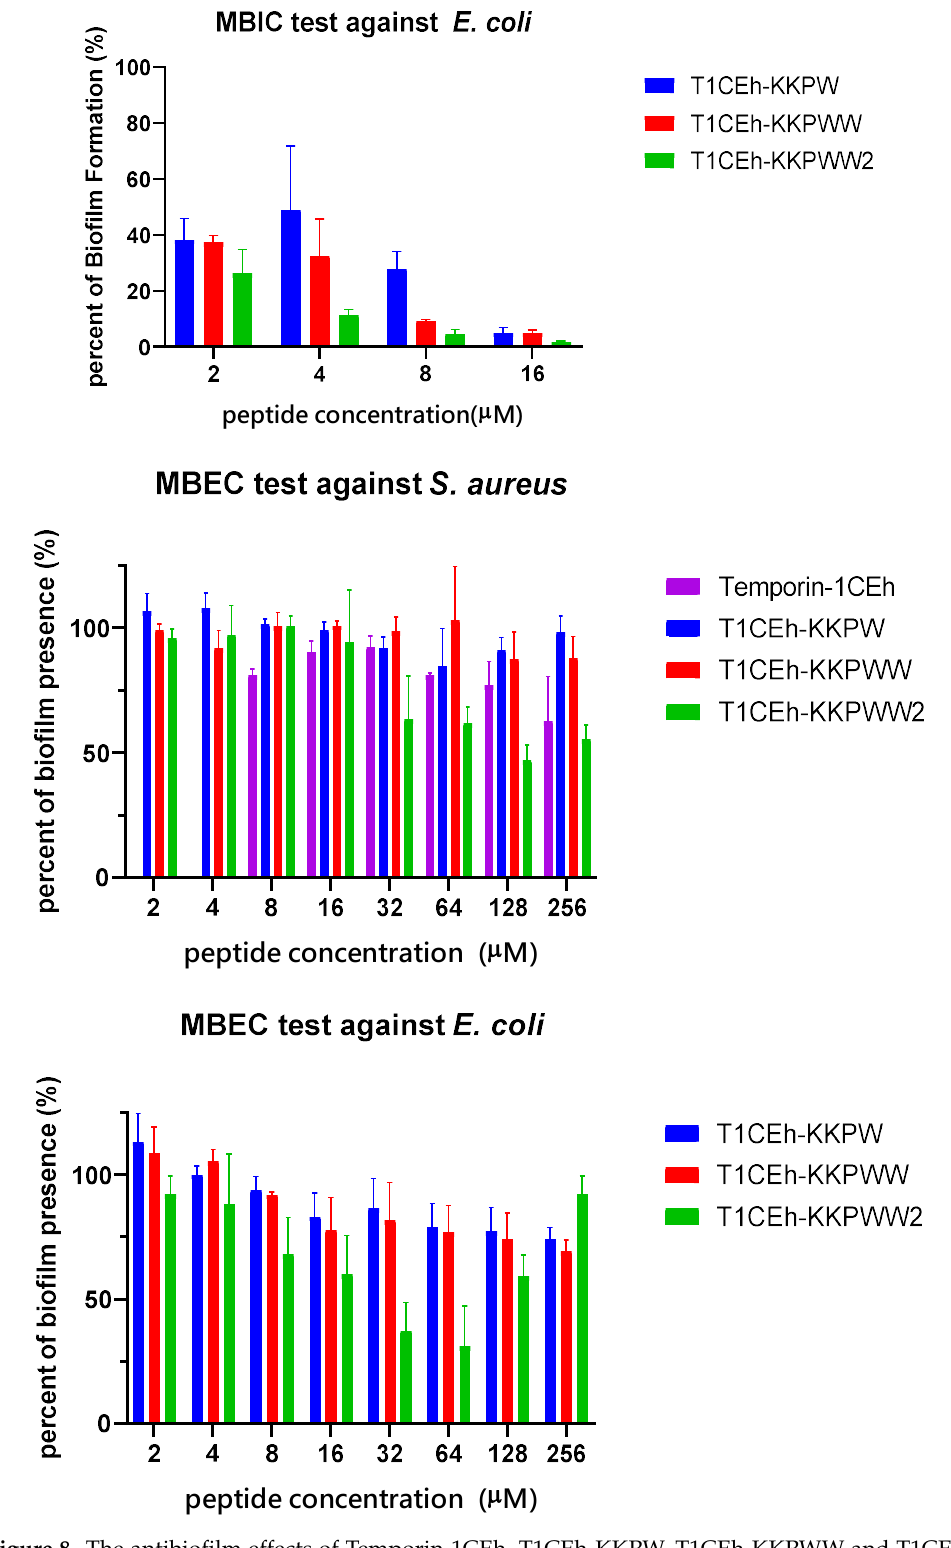
Figure 8. The antibiofilm effects of Temporin-1CEh, T1CEh-KKPW, T1CEh-KKPWW and T1CEh- KKPWW2 against S. aureus (ATCC CRM 6538) and E. coli (ATCC 8739). Error bars represent the SEM of three replicates.